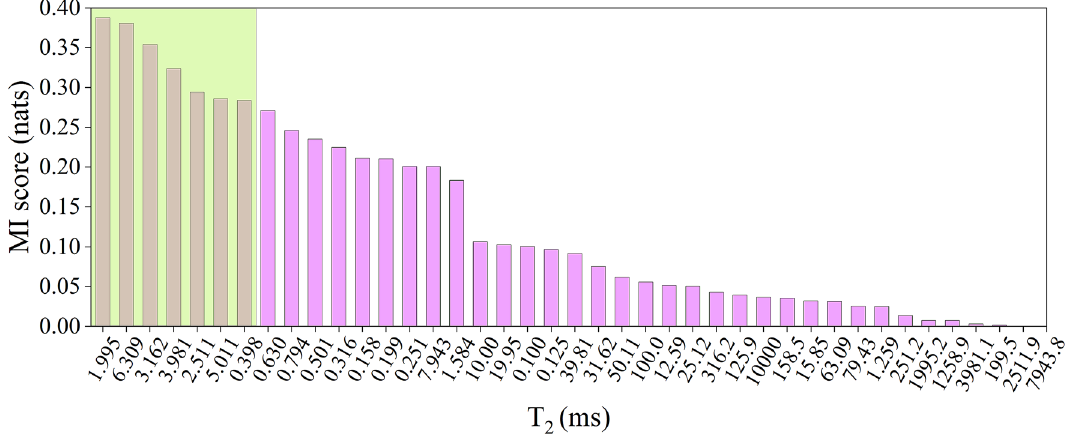
Figure 4. Results of the mutual information regression applied to the training set T 2 distributions of the oil- sand samples relative to the Dean-Stark water content (DS-w). The shaded area presents the continuous cluster of T 2 responses with a strong mutual association with DS-w, which were used for the calculation of the T 2 cutoff range parameter – T 2cr